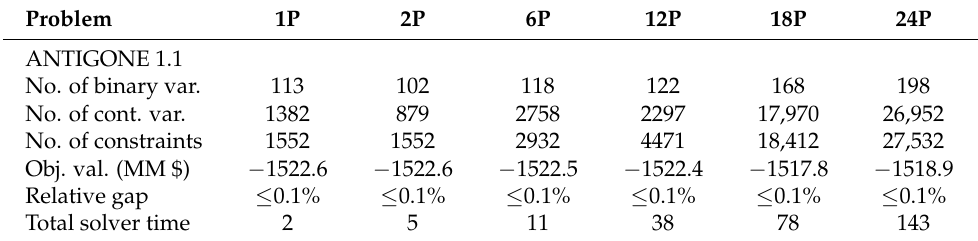
Table 4. Multi-period solution summary for Case A (unit for time: seconds).